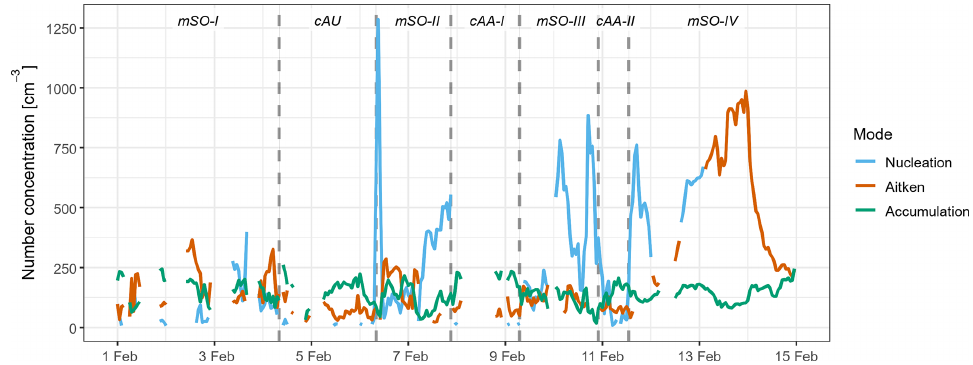
Figure 4. Aerosol number concentrations in the nucleation (blue), Aitken (brown), and accumulation (green) modes, as derived from the fitted size distributions. Periods influenced by different air masses are labelled and delimited by dotted lines. Blank regions represent missing data due to contamination from ship emissions or instrument maintenance.